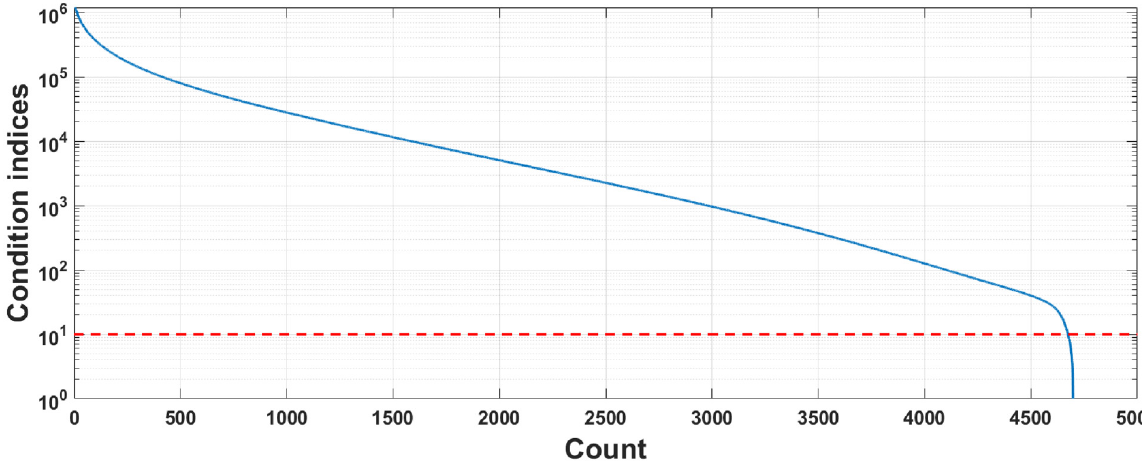
Fig 1. Condition indices of phoneme frequency